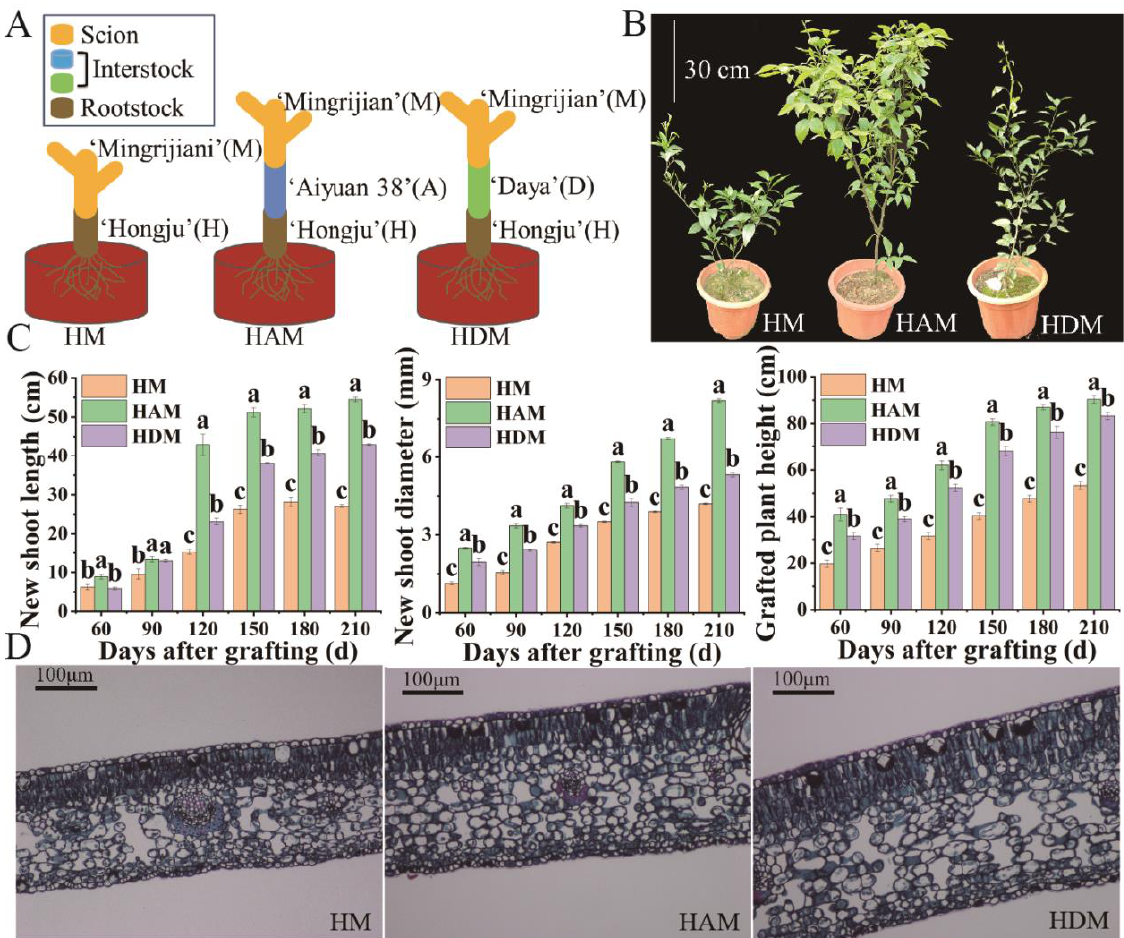
Figure 1. The effect of interstocks on the growth responses of ‘Mingrijian’ citrus. ( A ) Grafting diagram of seedlings used in this experiment. ( B ) Effects of interstocks on the growth morphology of ‘Mingrijian’ after 210 days. ( C ) The length of new shoots, diameter of new shoots, and plant height of grafted seedlings under different interstocks. Abscissa coordinates represent different days after grafting. Longitudinal coordinates represent the increment of indexes. Data were the mean ± standard error of three replicates. Error bars indicate the standard error of total growth, and different letters indicate significant differences in total growth, p < 0.05. ( D ) Leaf cross - cutting structure (×200) of ‘Mingrijian’ after 210 days of grafting onto different interstocks.